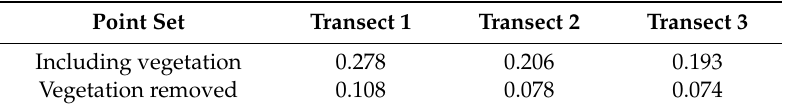
Figure 4. Comparison between GPS measured bare earth profile and drone derived profiles with and without vegetation points included: ( a ) transect 1; ( b ) transect 2; ( c ) transect 3. Table 2. Mean absolute errors between RTK-GPS measured and drone derived elevations for the three transects over the frontal